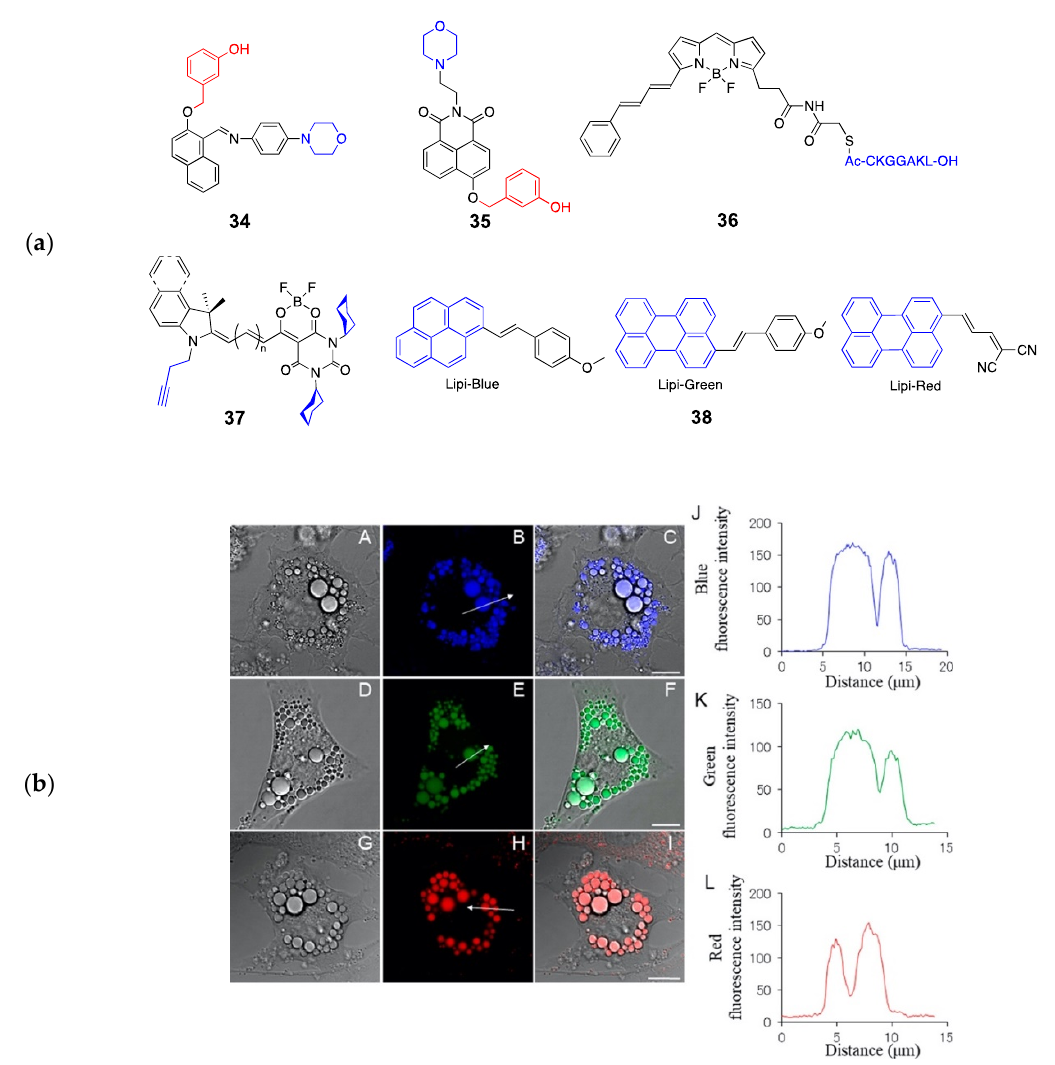
Figure 9. ( a ) Structures of probes targeting melanosomes ( 34 – 35 ), peroxisomes ( 36 ), and lipid droplets (LD) ( 37 – 38 ) (blue: targeting moiety; red: responsive moiety); ( b ) Fluorescence imaging of brown adipocytes stained with Lipi-probes ( 38 )—Lipi-Blue (A–C), Lipi-Green (D–F), Lipi-Red (G–I). Images of differential interference contrast. (B, E, and H) Images of fluorescence. (C, F, and I) Images of overlay. The graphs on the right are results of the line-scan analysis: B, Lipi-Blue; E, Lipi-Green; or H, Lipi-Red. (J, K, and L) Fluorescence intensity of the range indicated by the arrows shown in parts B, E, and H, respectively. Scale bar is 10 µm. Reprinted with permission from ref. [97]. Copyright 2019 American Chemical Society.